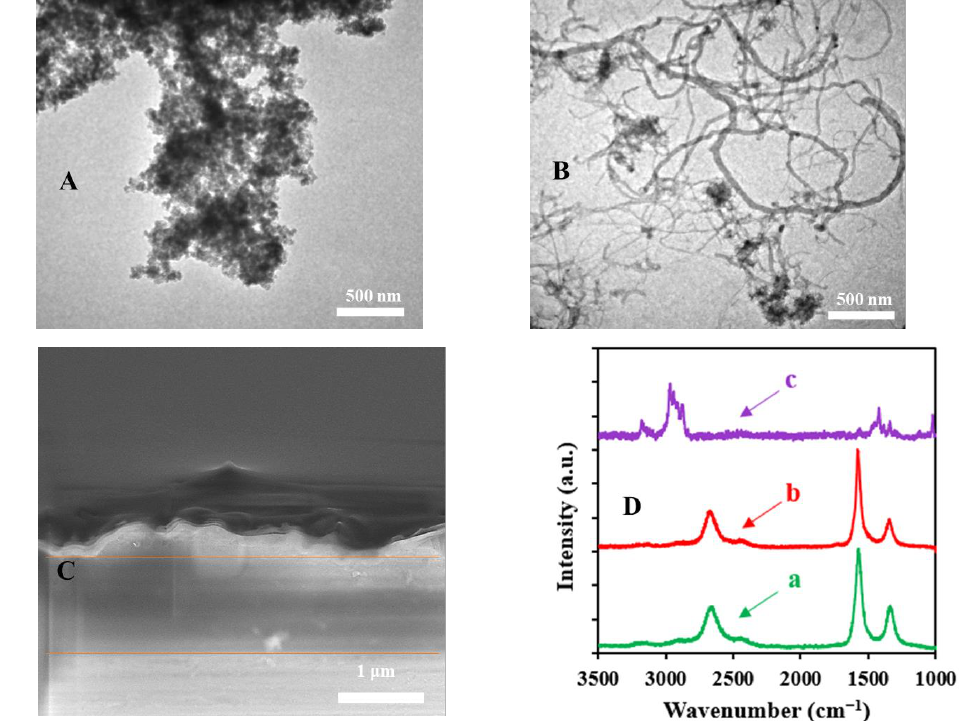
Figure 2. TEM images of MWCNTs ( A ) and CMC-MWCNTs ( B ), SEM images of CMC-MWCNTs- IL ( C ), and Raman spectra ( D ) for MWCNTs (a), CMC-MWCNTs (b), and CMC-MWCNTs-IL